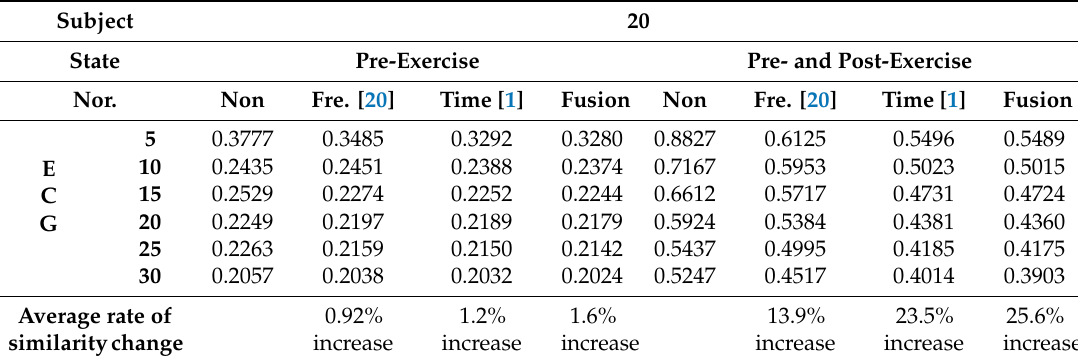
Figure 9. ( a ) ECG cycles before and after exercise ( b ) ECG cycles before and after exercise: existing normalization ( c ) ECG cycles before and after exercise: time normalization ( d ) ECG cycles before and after exercise: fusion normalization.